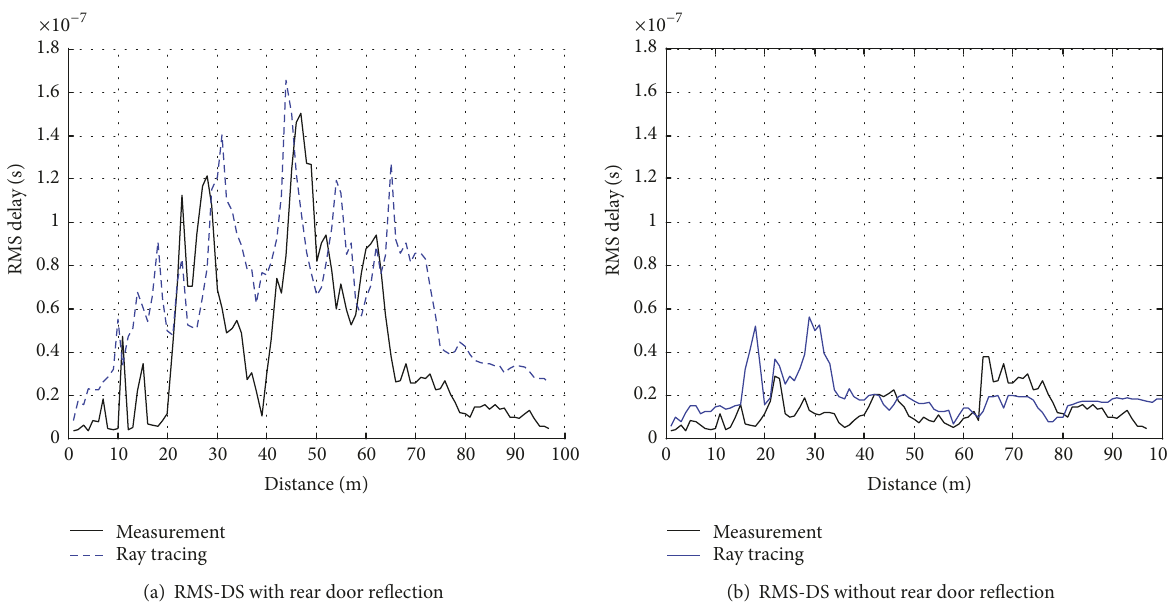
Figure 5: RMS-DS versus distance for measurement and ray tracing results.